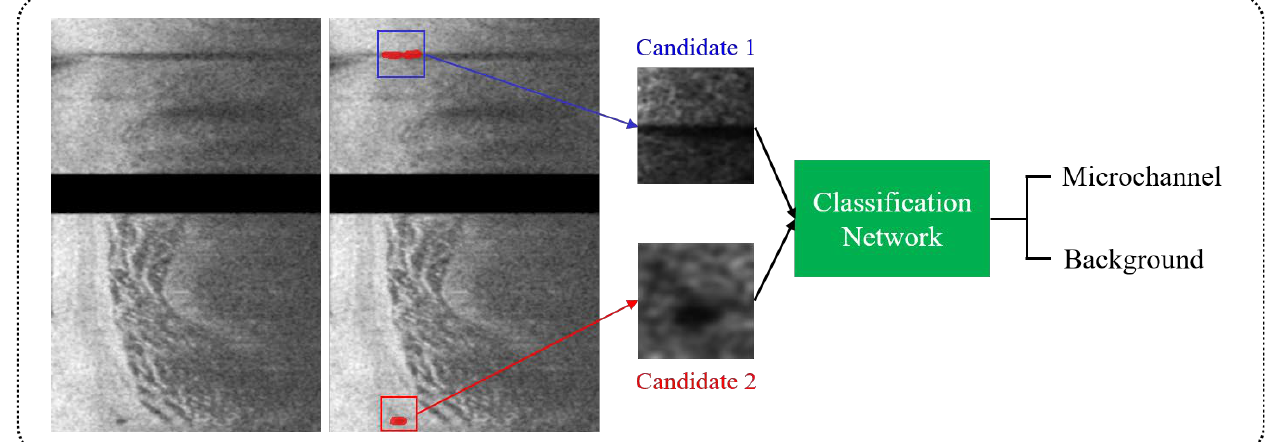
Figure 2. Classification of microvessel candidates using a simple CNN model. Each candidate was classified as either microvessel or non-microvessel using a CNN model (green) consisting of three convolutional, two maximum pooling, and one fully connected layers. The red box is a microvessel, and the blue box is a non-microvessel.